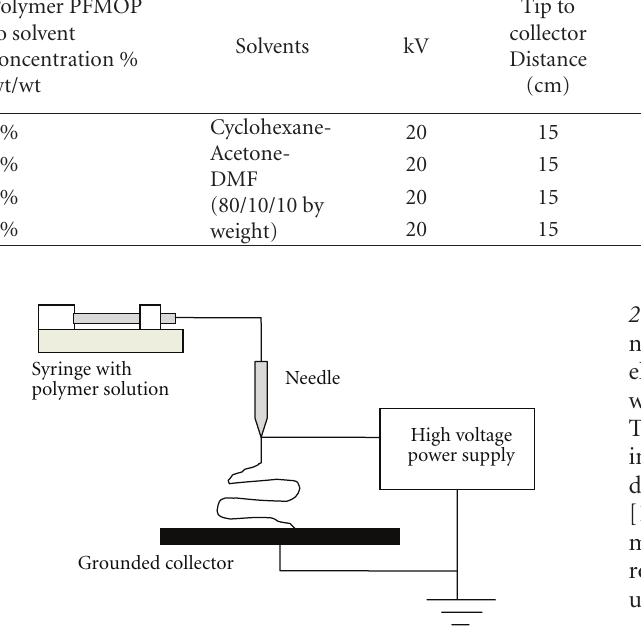
Figure 1: Schematic of a laboratory electrospinning setup.